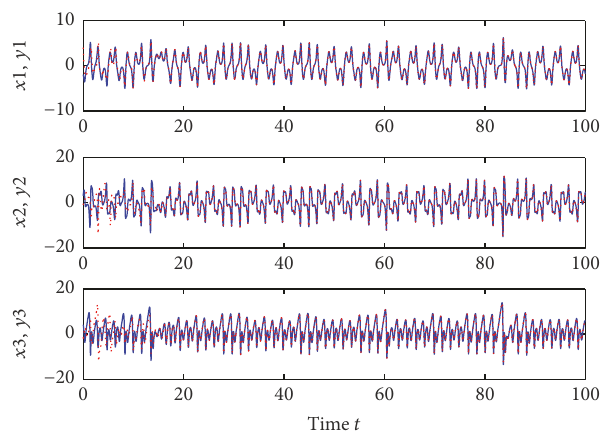
Figure 3: The figure shows that 𝑥 1 , 𝑥 2 ,𝑥 3 are synchronized to 𝑦 ,𝑦 , 𝑦 1 2 3